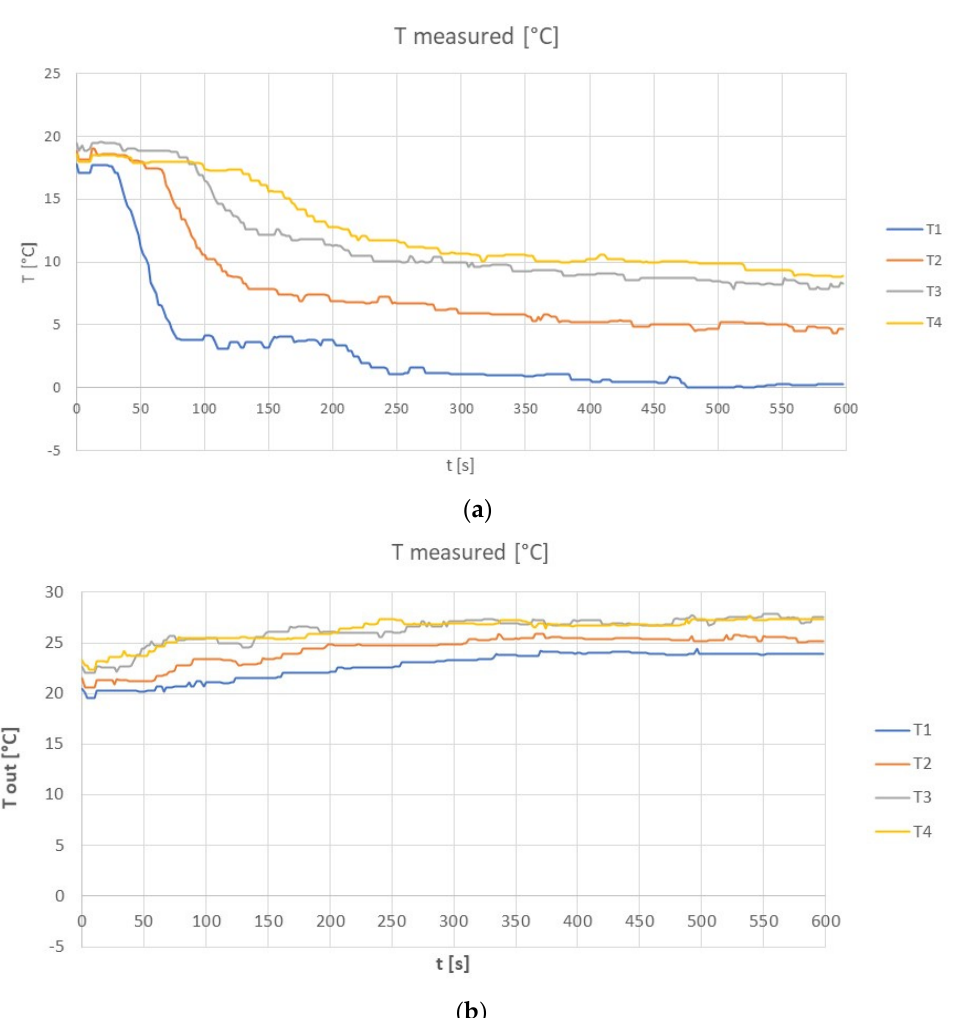
Figure 8. The air temperature in the staircase in the representative experiments ( a ) in winter (23 February 2019) and ( b ) in summer (30 June